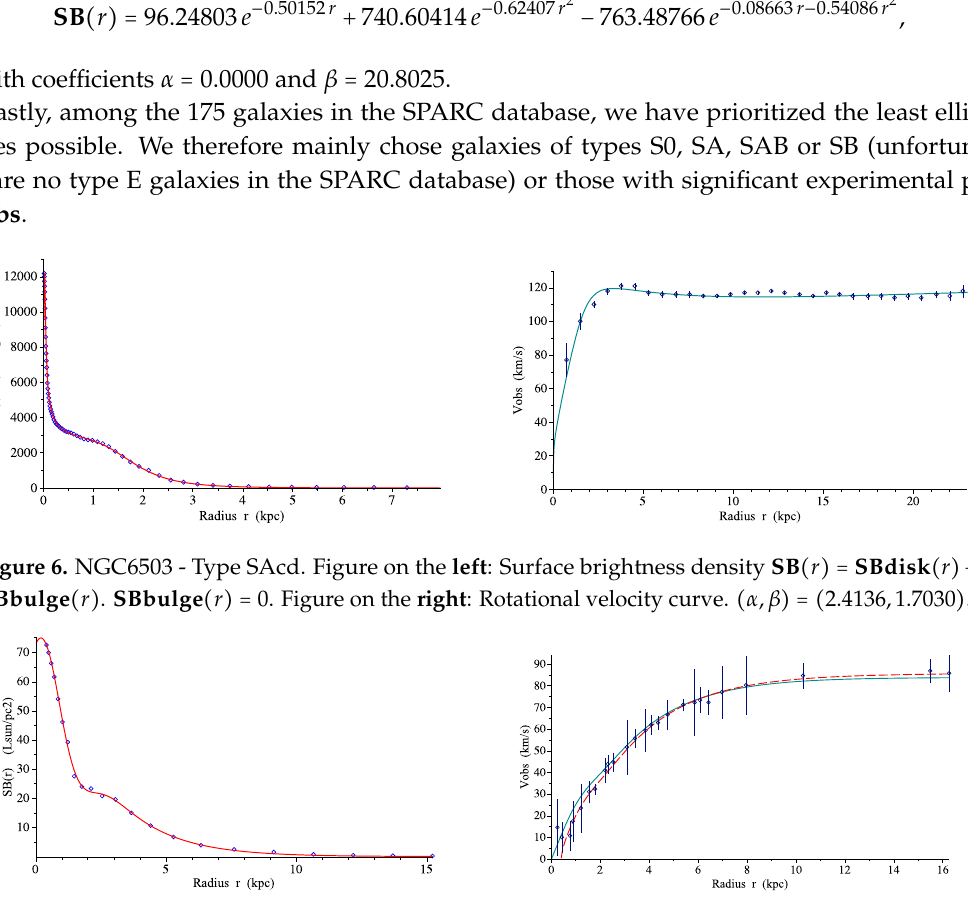
Figure 7. LSBC F583-01—Type Sm. Figure on the left : Surface brightness density SB ( r ) = SBdisk ( r )+ SBbulge ( r ) . SBbulge ( r ) = 0. Figure on the right : Rotational velocity curve. Green solid curve: ( α , β ) = ( 0.0000,20.8025 ) . Red dashed curve: ( α , β ) = (− 9.015,22.233 )